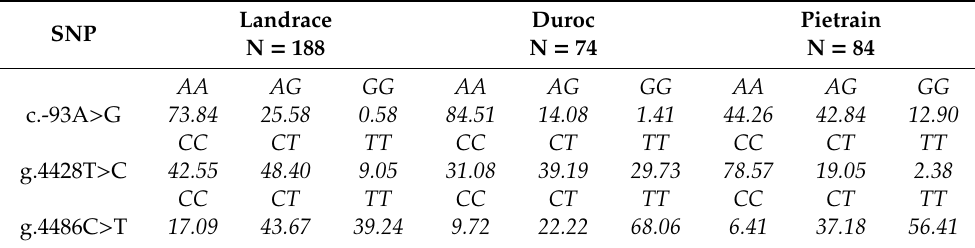
Table 4. The frequencies of genotypes (%) between di ff erent SNP for analyzed breeds. Landrace SNP N = 188